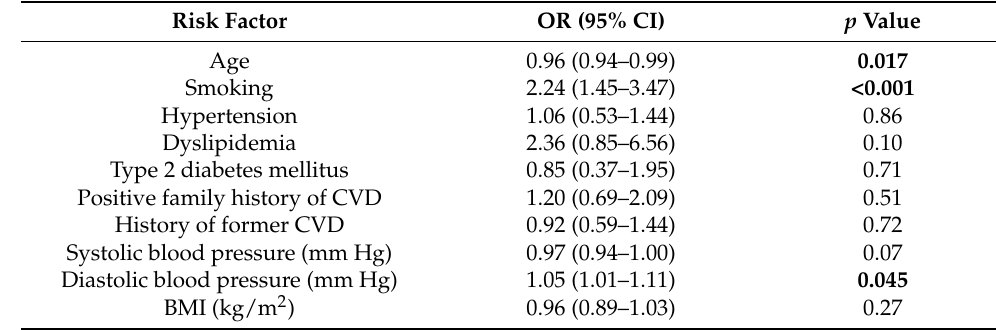
BMI—body mass index. The bold are statistically significant